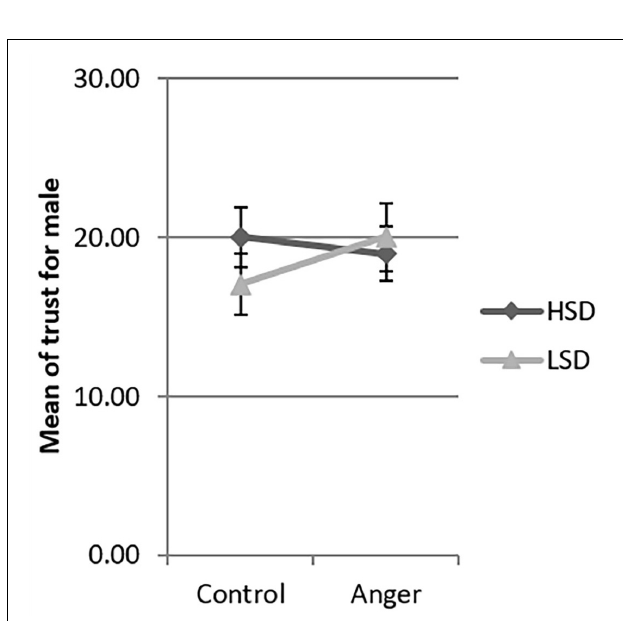
FIGURE 3 | Mean of trust of male across the four experimental conditions in Study 1. LSD, low social distance; HSD, high social distance. Error bar is the standard